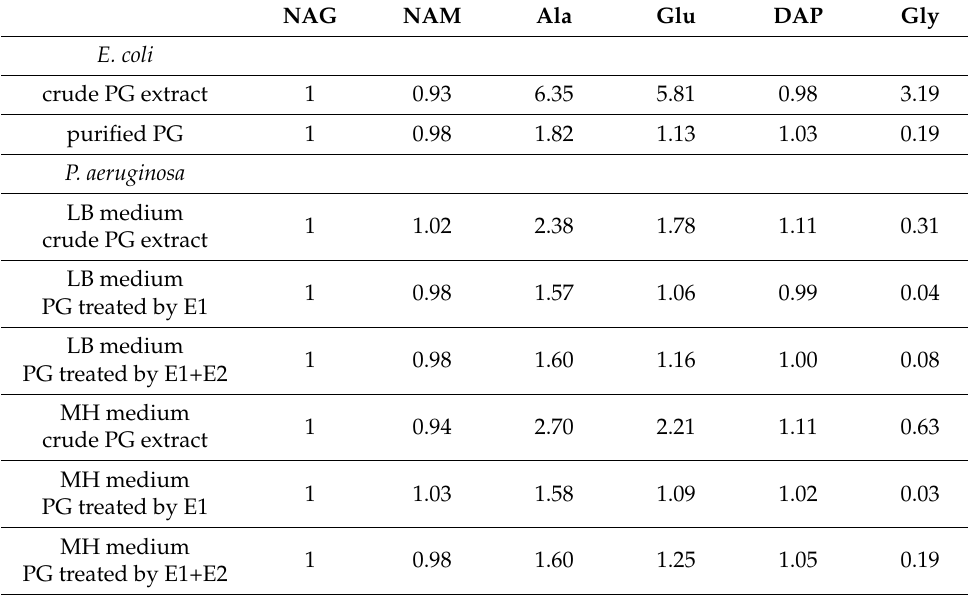
Table 1. PG composition of E. coli and P. aeruginosa bacterial strains normalized to the NAG